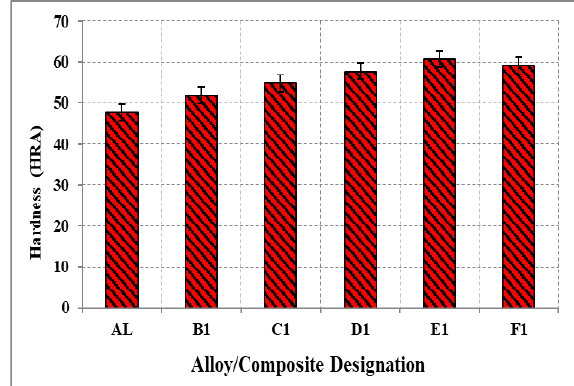
Figure 5. Hardness of unreinforced and graphene/CNT reinforced aluminium hybrid composites.